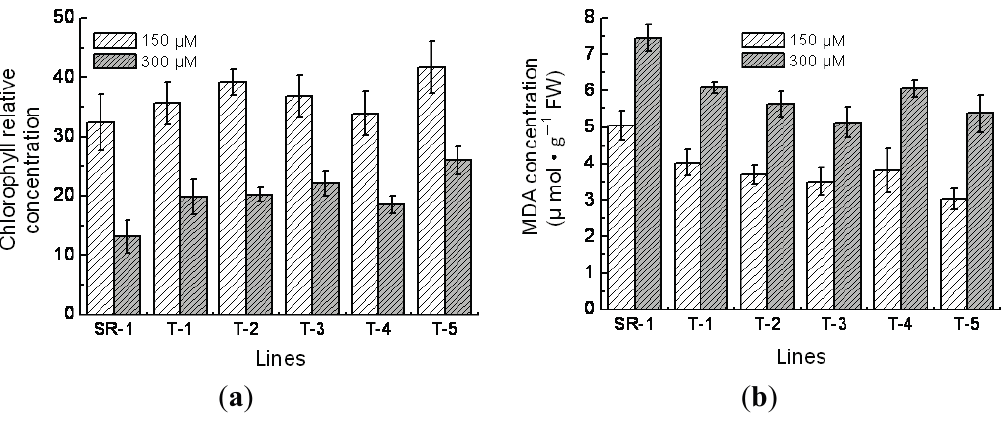
Figure 5. Comparison of chlorophyll ( a ) and malondialdehyde (MDA) ( b ) concentration between transgenic and non-transgenic tobacco lines. SR-1, non-transgenic tobacco; T-1 to T-5, transgenic tobacco. Mean values and standard deviations were calculated based on the six replicates.